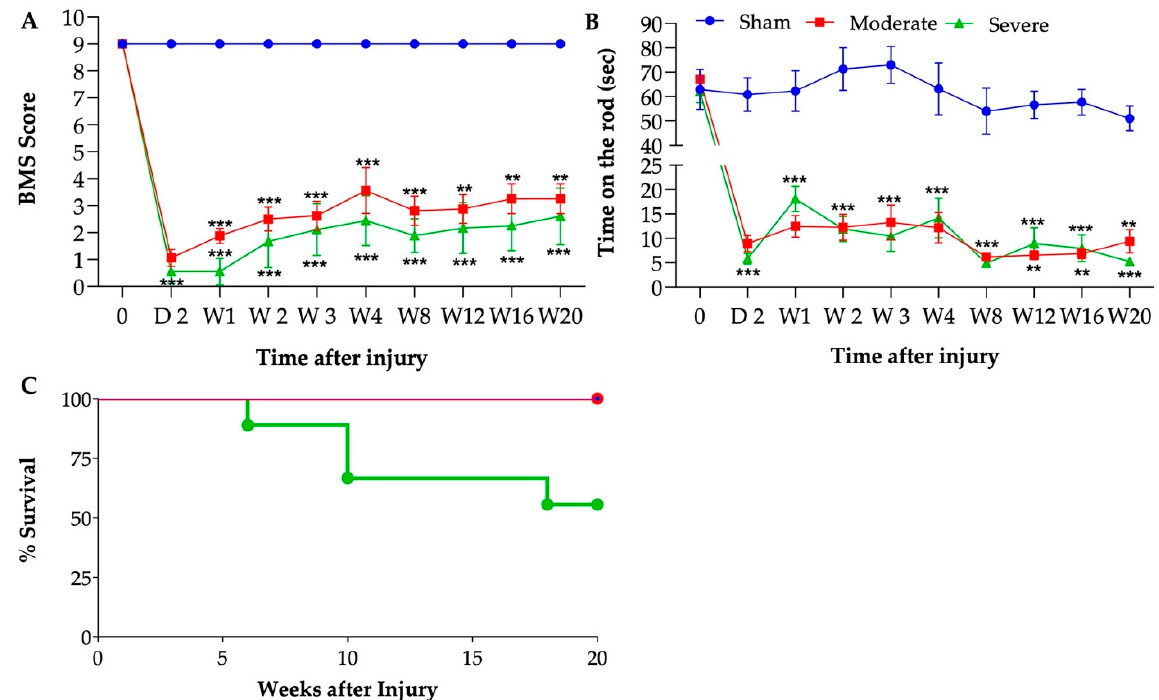
Figure 2. Behavioral testing after SCI. BMS scores ( A ), Rotarod score ( B ). Behavioral tests performed at baseline before injury and on days 2, 7, 14, 21, 28, and then monthly PI. ( C ) Percent survival during the experiment. Repeated measures two-way ANOVA: Tukey’s multiple comparisons test was used to determine the differences between the groups. Data presented as means ± SEM, n = 5–9 per group. * p ≤ 0.03, ** p ≤ 0.002, *** p ≤ 0.001.